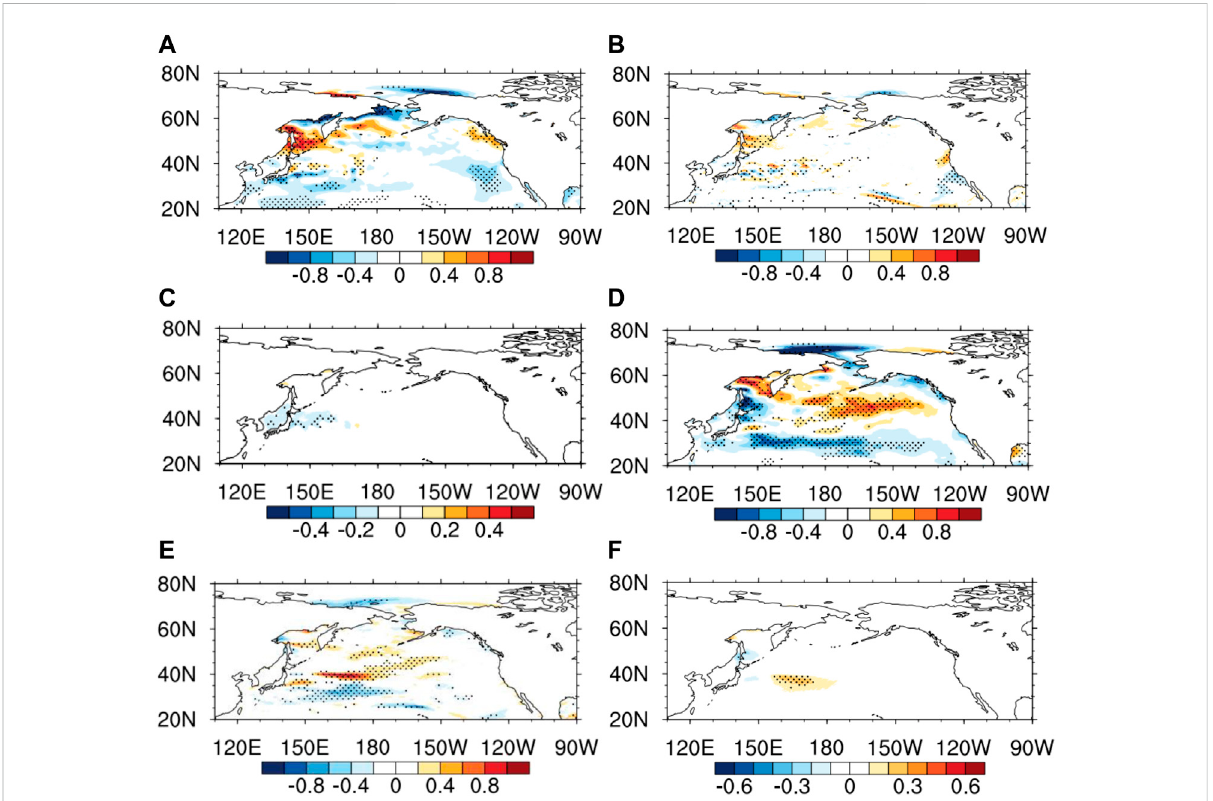
FIGURE 6 Baroclinicgrowthrateanomaly(10 – 6 s – 1 ,shading)todifferentscalesofKE-relatedSSTAsat700 hPa: (A) Baroclinicitygrowthrateinresponseto KE-related mesoscale SSTAs (KSTS-MEFS). (B) Baroclinicity caused by meridional gradient of potential temperature in response to KE-related mesoscale SSTAs (KSTS-MEFS). (C) Baroclinicity caused by atmospheric static stability N in response to KE-related mesoscale SSTAs (KSTS-MEFS). (D – F) The same as (A – C) but for KE-related large-scale SSTAs (MEFS – CTRL). Statistically signi fi cant differences at 90% according to Student ’ s t test are stippled.